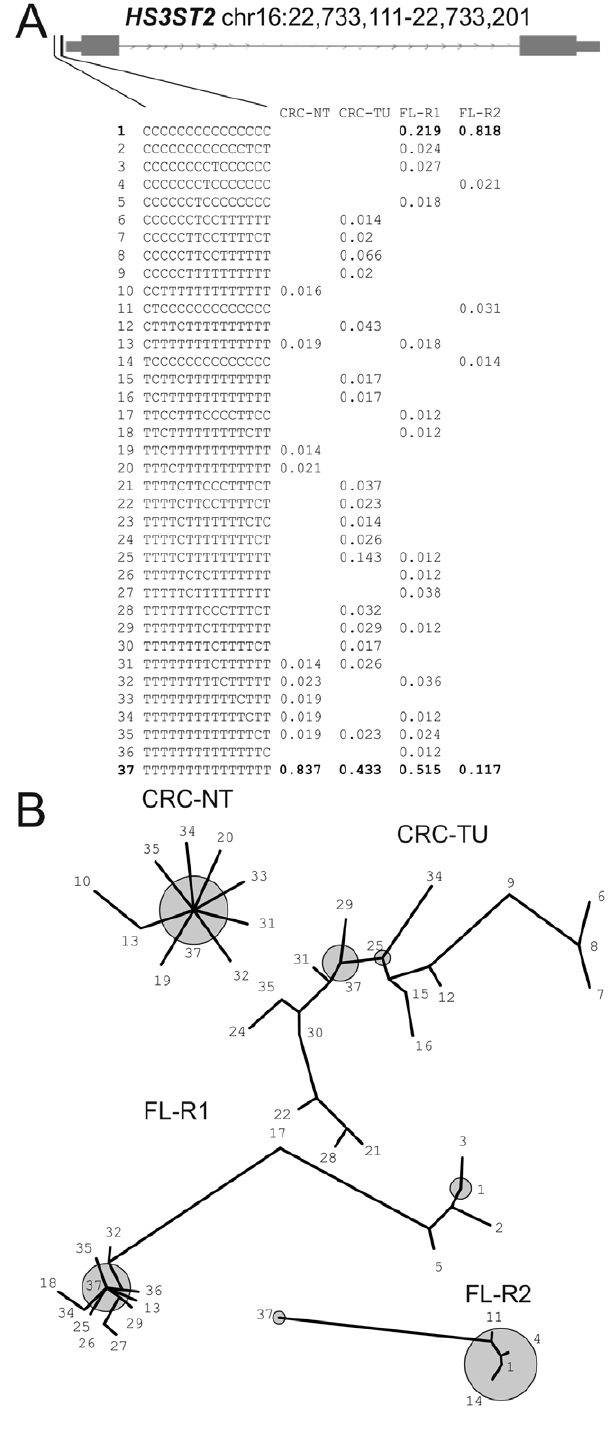
Figure 7. Hepitype diversity at the HS3ST2 (heparan sulfate 3- O-sulfotransferase 2) locus on chromosome 16 (22,733,111– 22,733,201 bp) is characterized by increasing methylation in tumor samples. In panel A, the hepitype frequencies in the four samples and an overview of the locus structure is given. Panel B shows maximum-parsimony trees constructed from hepitypes with a mini- mum frequency of 1%. The numbered hepitypes from panel A are annotated in the trees. The frequent hepitypes are indicated by grey circles sized according to the relative frequencies. Trees have been constructed separately and branch lengths are thus not to scale. It is evident, that both in comparison between normal tissue and tumor in